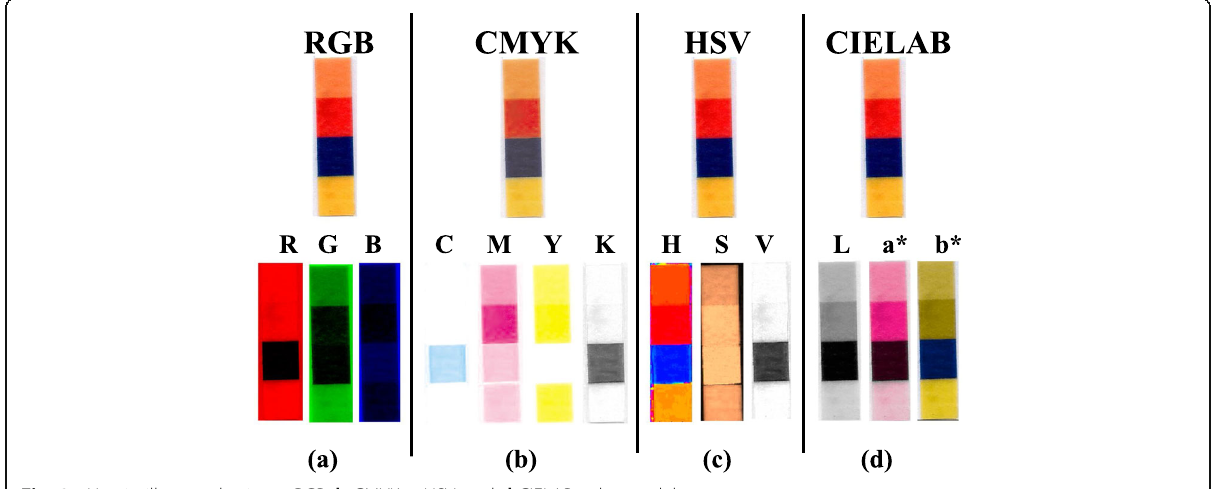
Fig. 3 pH strip illustrated using a RGB, b CMYK, c HSV, and d CIELAB color